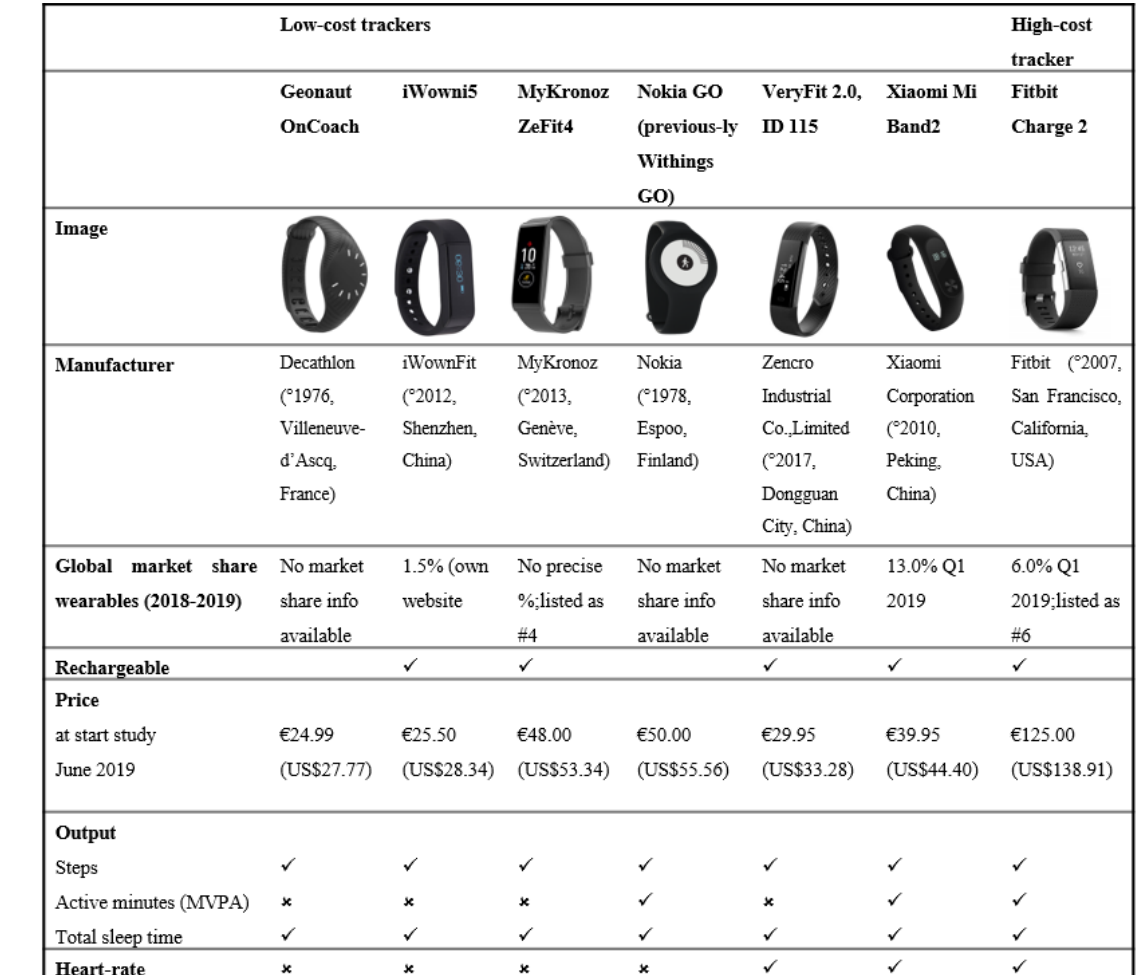
Figure 1. Tracker